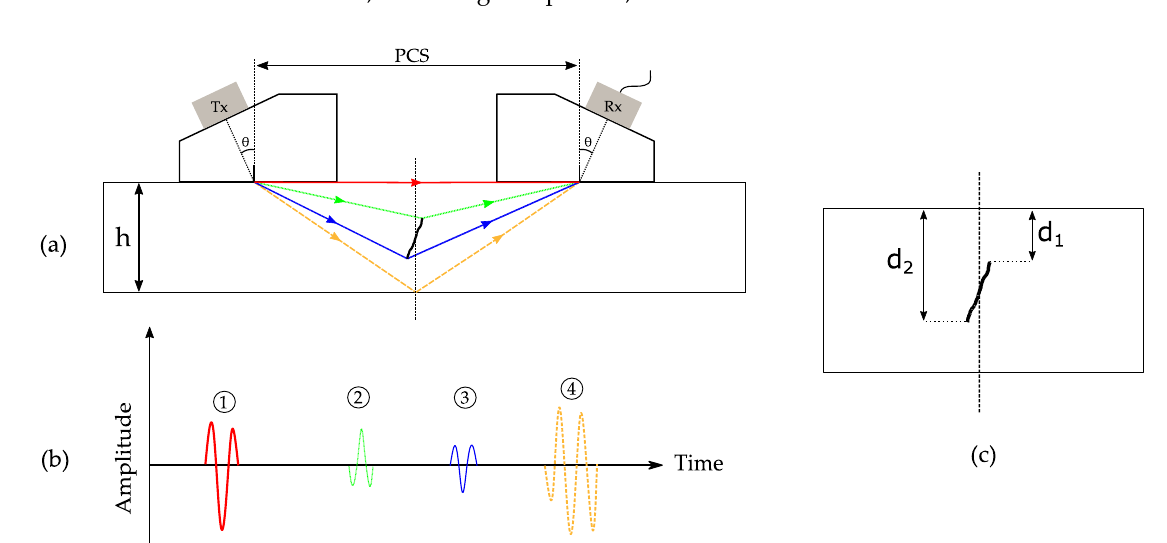
Figure 1. Time of flight diffraction principle: ( a ) setup constituted by two probes in opposition, mounted on a wedge of angle θ . The probes are separated by a distance, PCS (probe center spacing), and placed on a sample of thickness, h; ( b ) time traces as recorded by the receiving transducers displaying the lateral wave (1), the upper diffraction response (2), the lower tip diffraction response (3), and the backwall echo (4); ( c ) measurement of the depth and height of a defect.